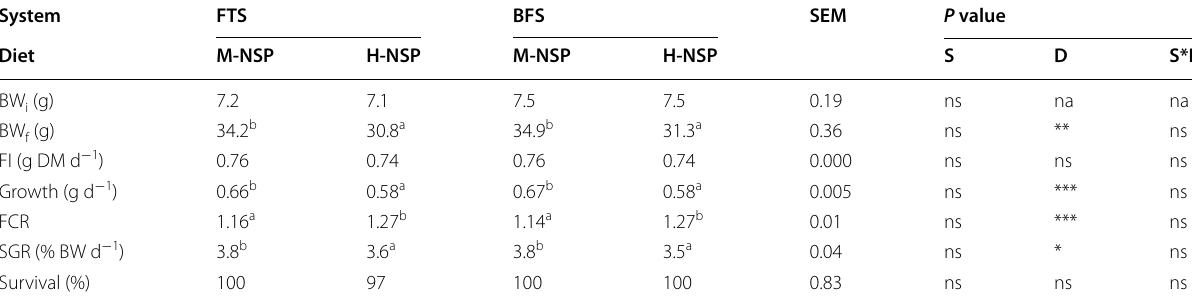
Table 1 Fish growth performance during Phase III (growth trial, 63—105